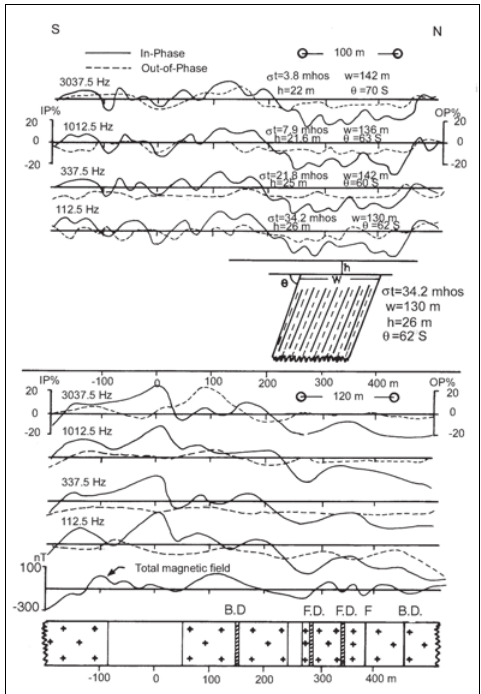
Fig. 10. Horizontal-loop EM profiles at several fre- quencies, coil separations and station separations with the corresponding total magnetic field profile along line C-C ′ (line 1200) and surface geology of the Abu- Shihat radioactive prospect area, North Eastern Desert, Egypt. Symbols as in fig.